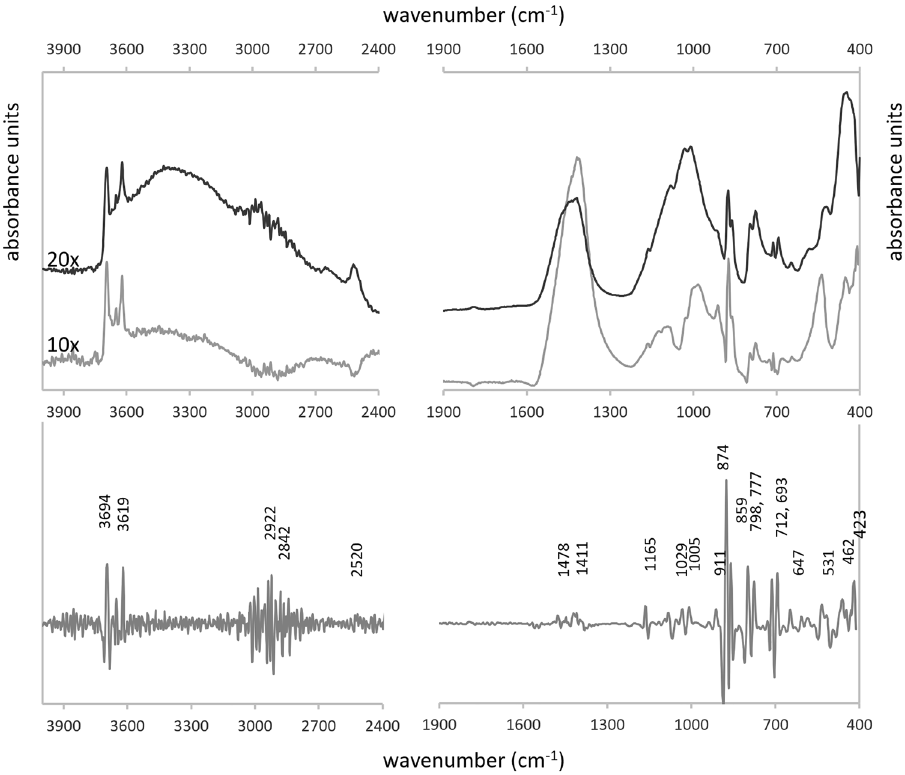
Figure 2. Top to bottom: average, standard deviation and average (reversed) second derivative spectra.